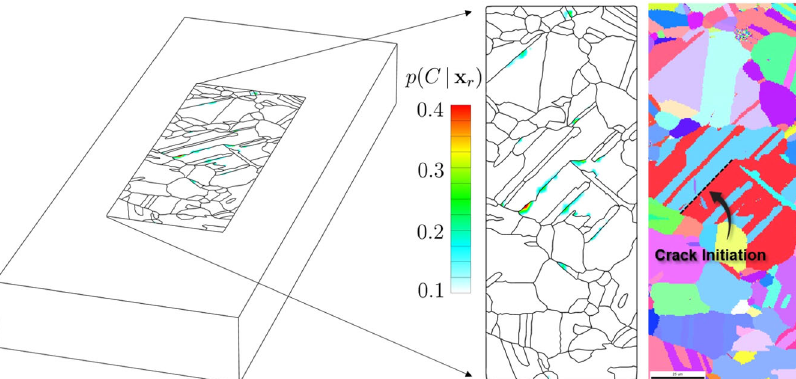
Fig. 5 Comparison of the crack nucleation model predictions with the observed crack locations of an experimental microstructure. The probability of crack nucleation predicted from the posterior distribution in an embedded microstructure of the concurrent multiscale model (red corresponding to the most probable), compared with the corresponding EBSD map and experimental nucleation site.